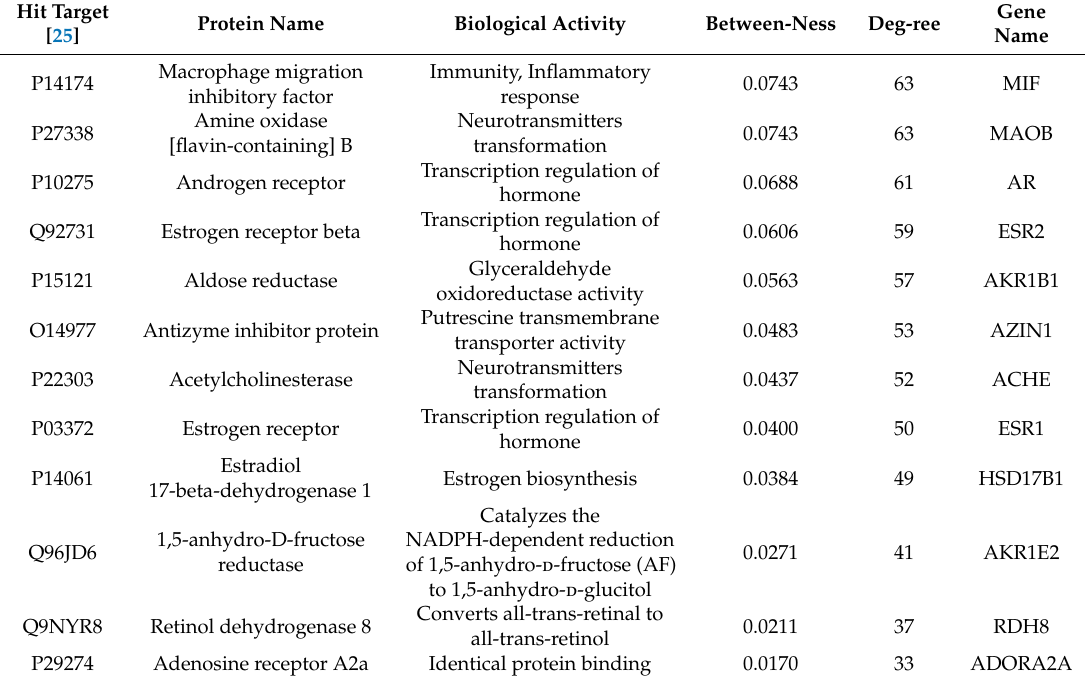
Table 2. Docking results of targets of